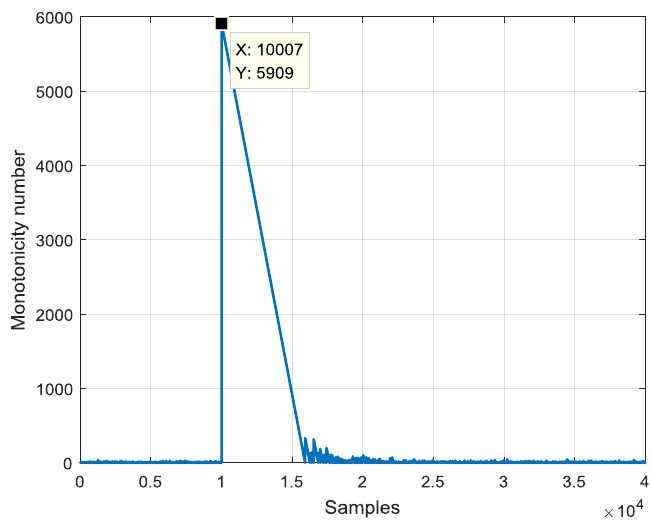
(cid:16) (cid:17) 0, 30 2 aF.